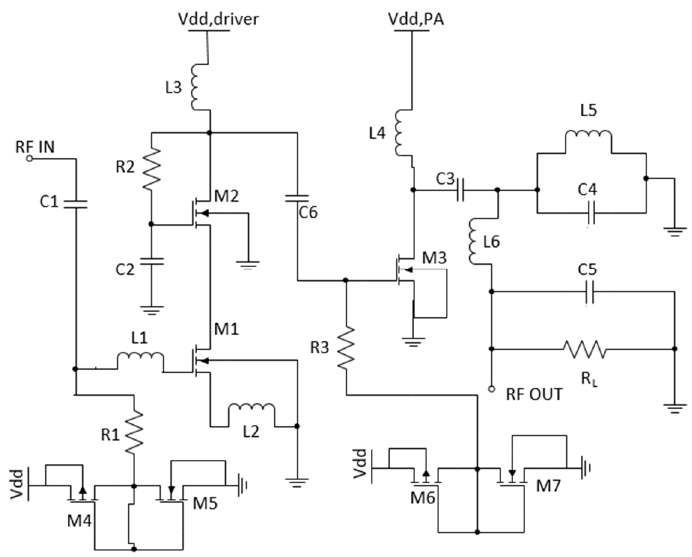
Figure 7. Schematic of two-stage CMOS PA [20].